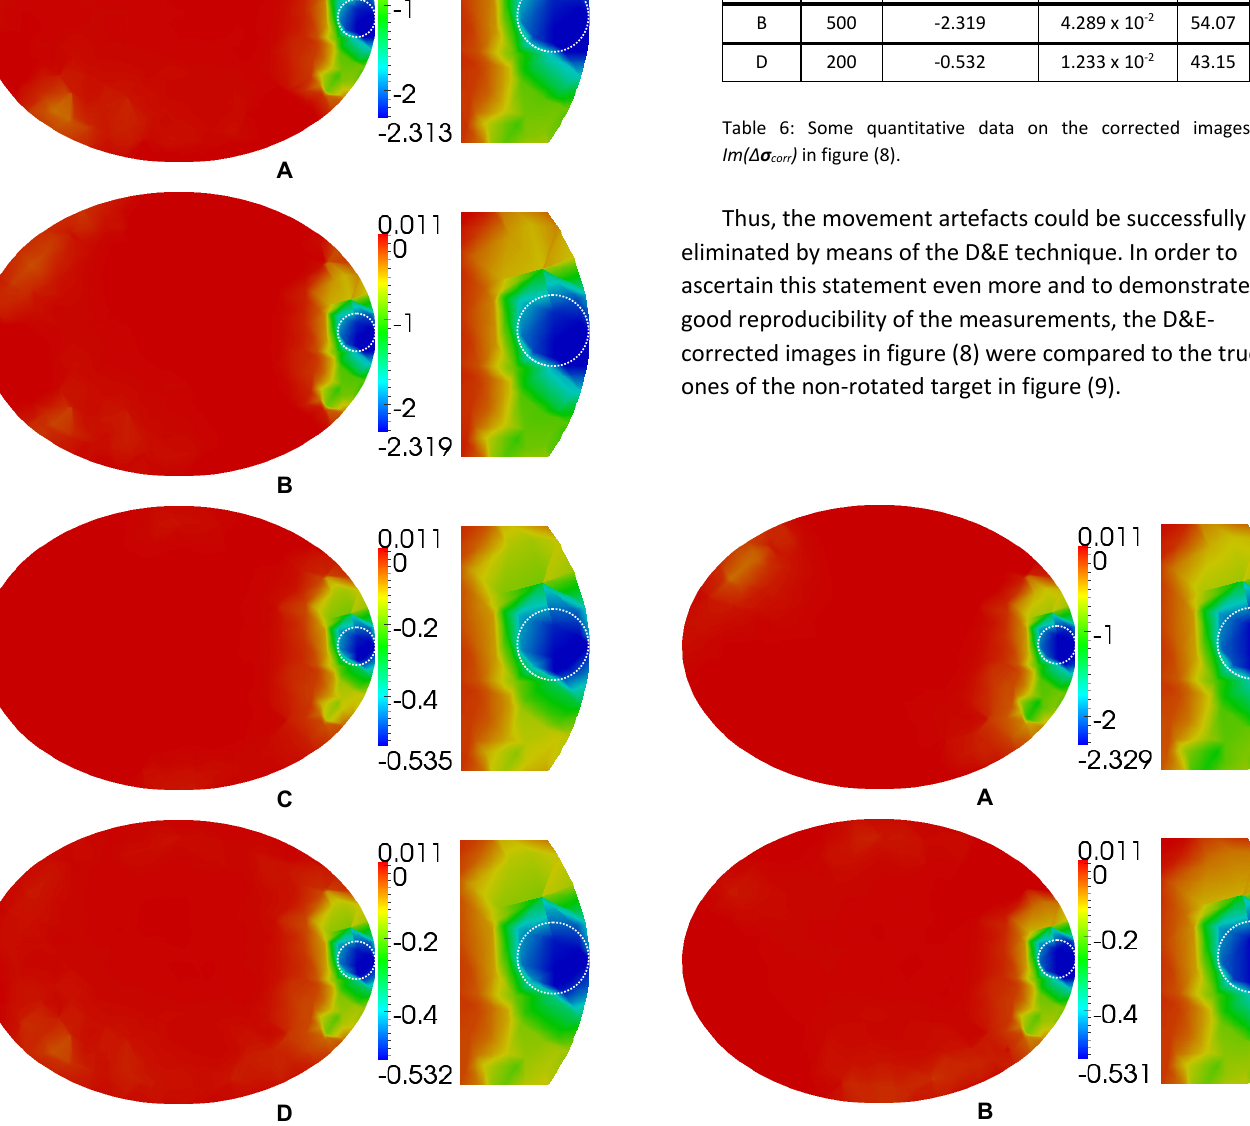
Fig. 8: Corrected versions Im(Δ σ corr ) of the erroneous images Im(Δ σ err ) in figure (6), respectively, after applying the D&E technique. The dotted white circle marks the same initial position of the sphere before rotation in the error detection measurements .